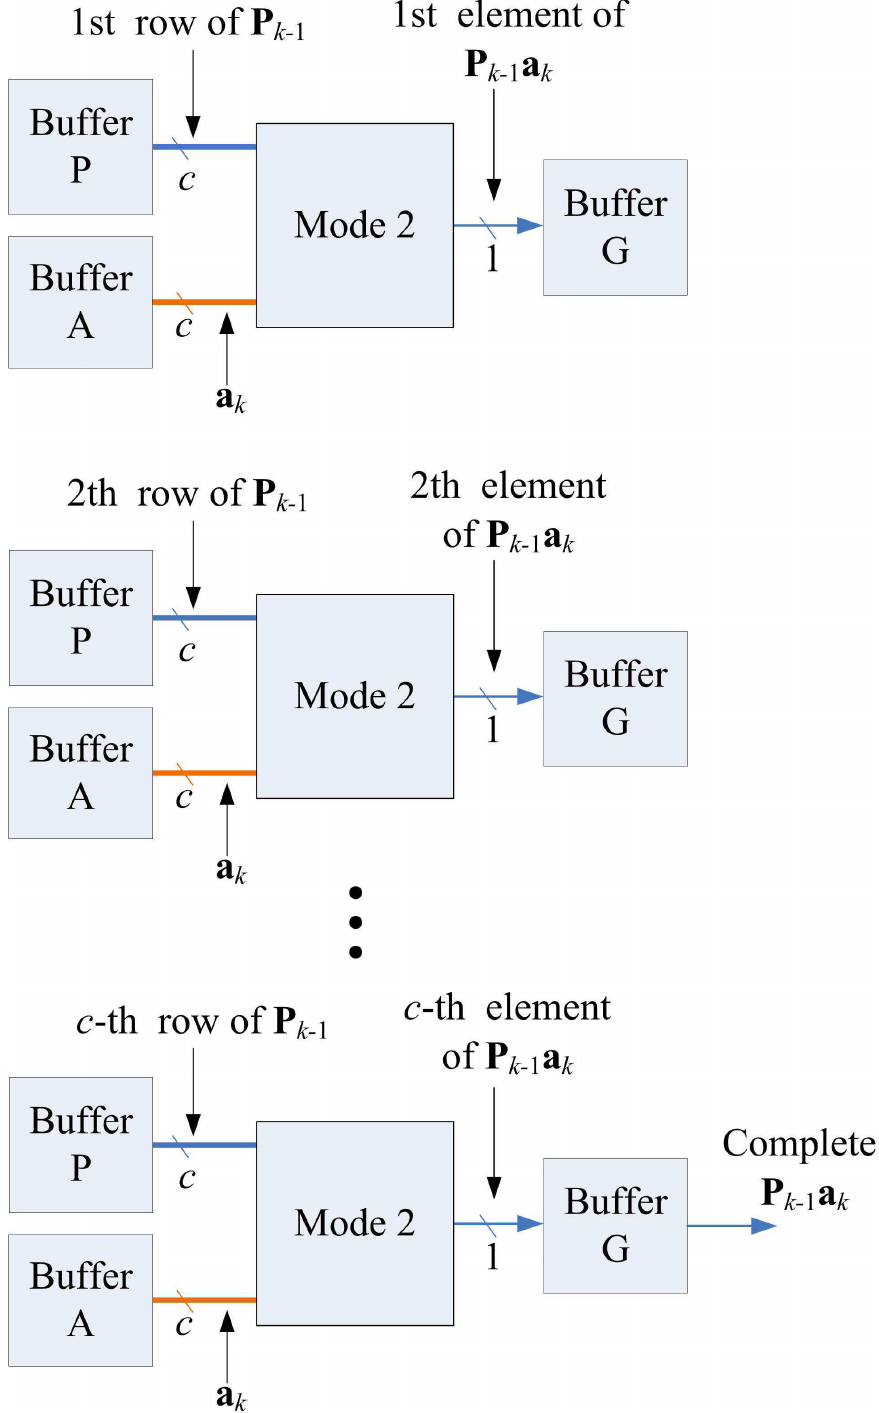
Figure 14. Multiple-step operations of state